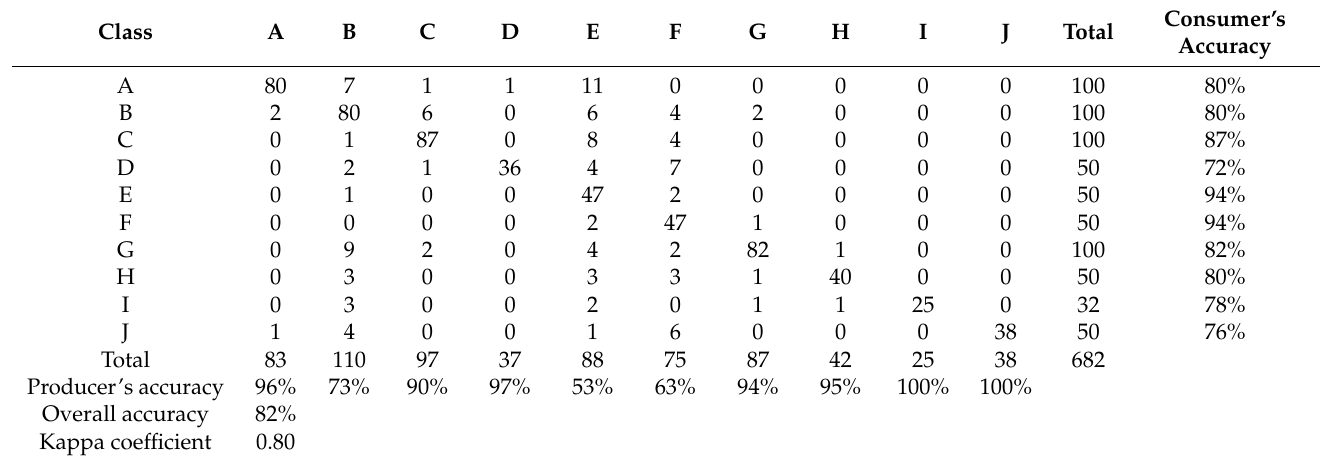
Table 2. Recognition results of the confusion matrix.